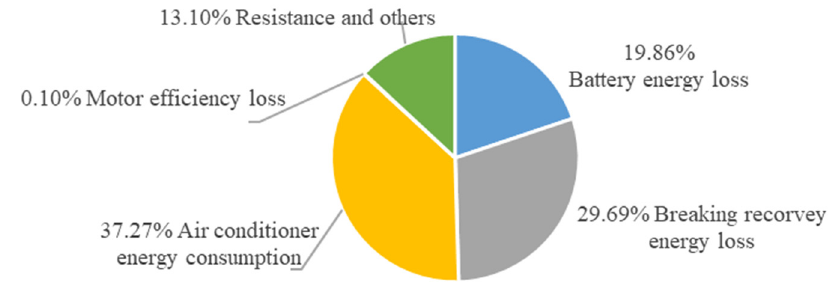
Figure 8. Pie chart of different factors’ contribution to range attenuation.